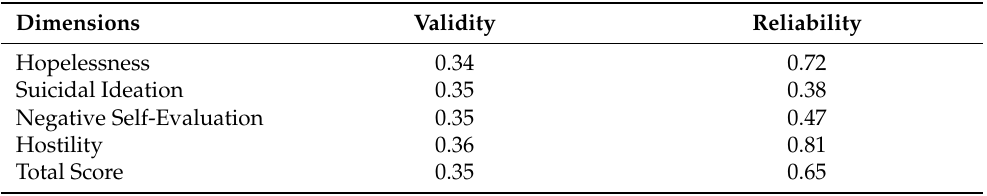
Table 5. Reliability and validity test results of suicide possibility identification model based on microblog text